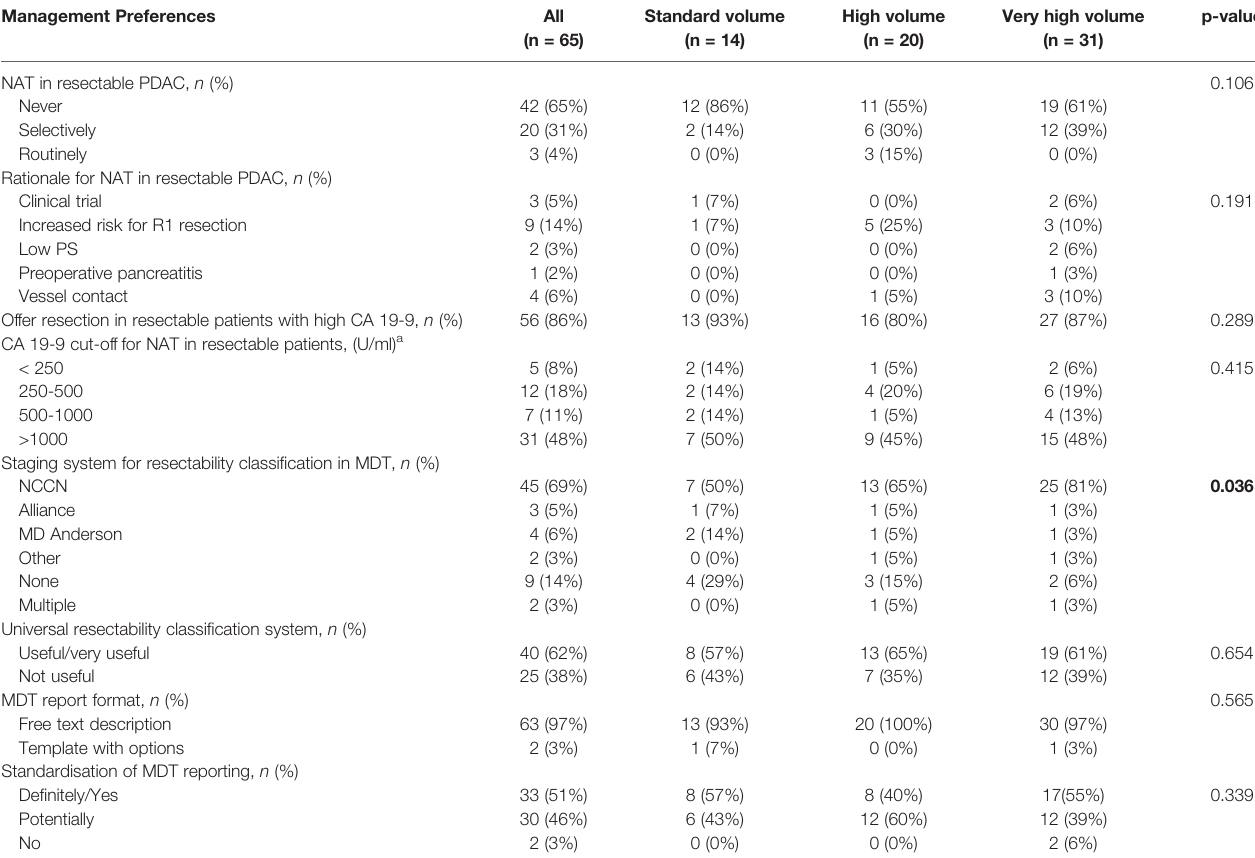
TABLE 1 | Surgeon preferences for management of non-metastatic pancreatic cancer strati fi ed by annual institutional volume of pancreatic resections. Management